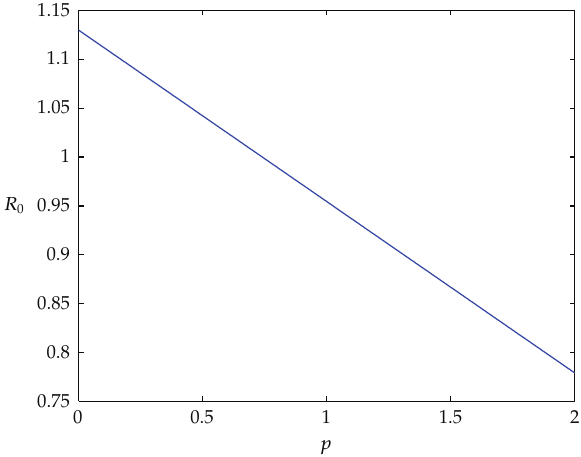
Figure 4: When p increased, R 0